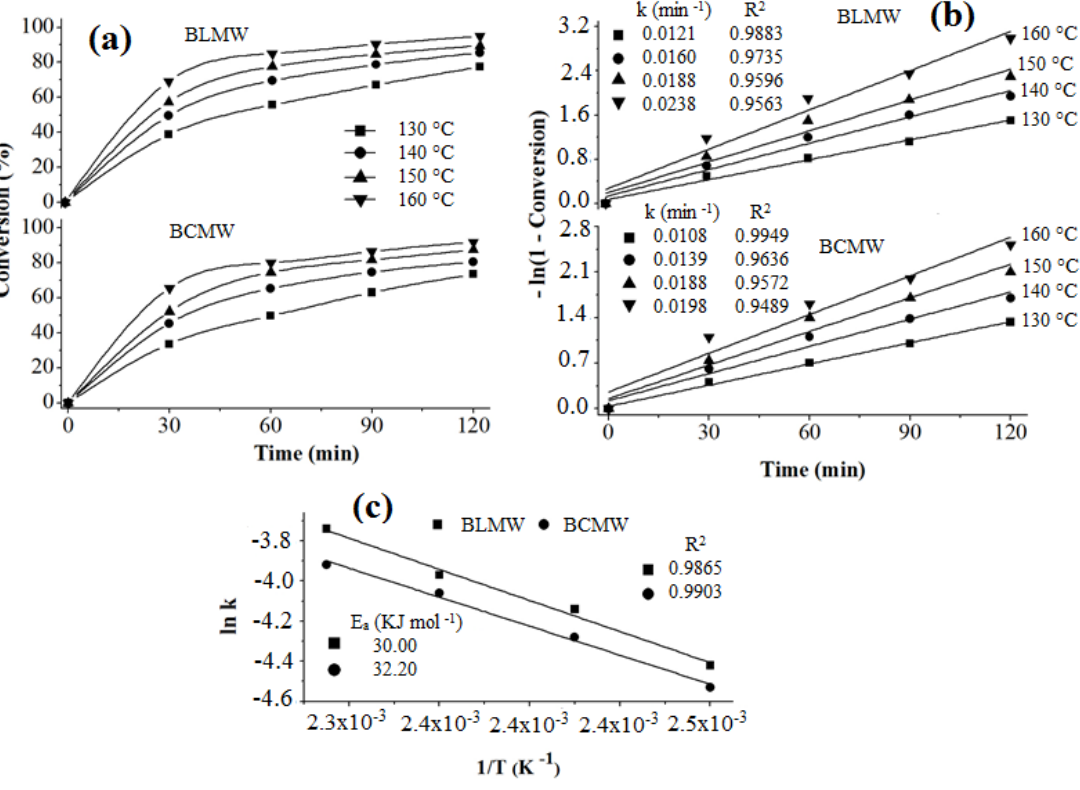
Figure 11. ( a ) The effect of time on conversion using the reaction conditions: Temperature 130–160 °C, DDPO:EtOH, 1:30 (molar ratio), catalyst amount 5.0%; ( b ) Plots of –ln (1 − conversion) versus time at different temperatures; ( c ) Arrhenius plot of ln(k) versus 1/T.